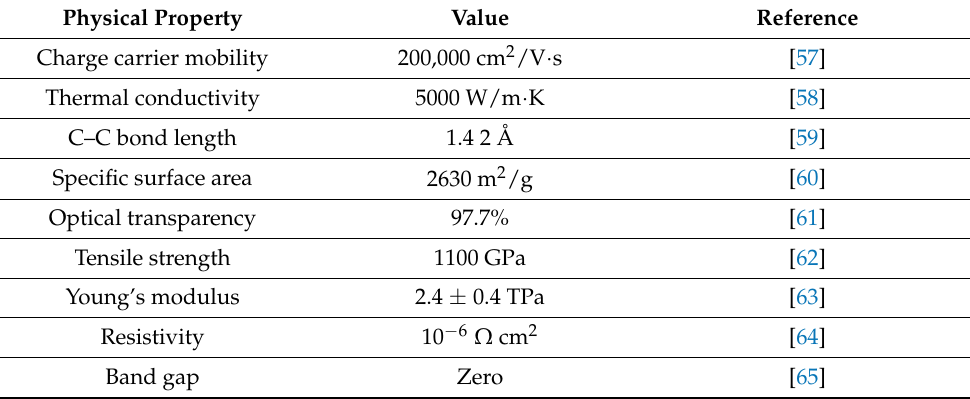
Table 1. Physical properties of